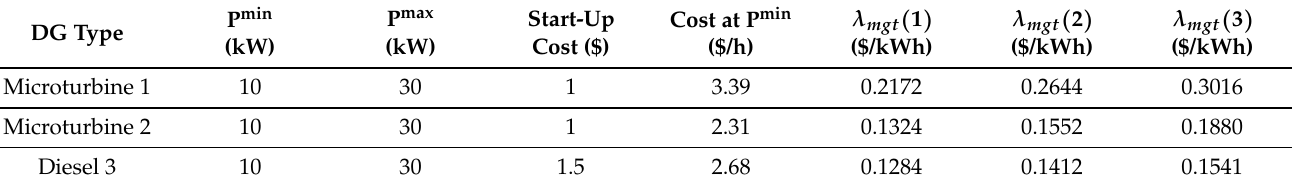
Table 2. Parameters of dispatchable DGs.